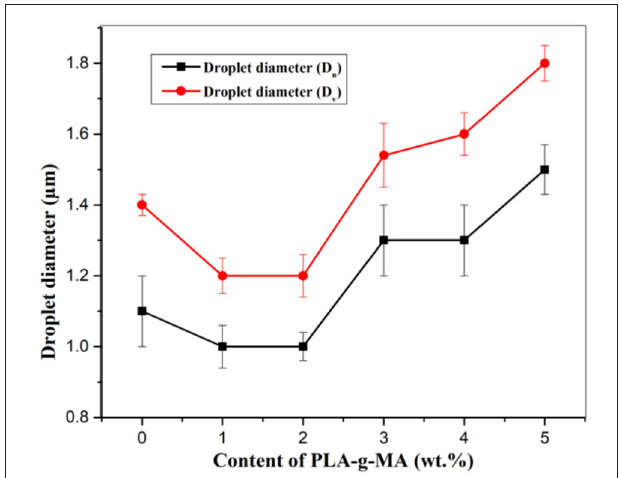
FIGURE 5 | Emulsification curve of PLA/PA12 blends with varying PLA-g-MA